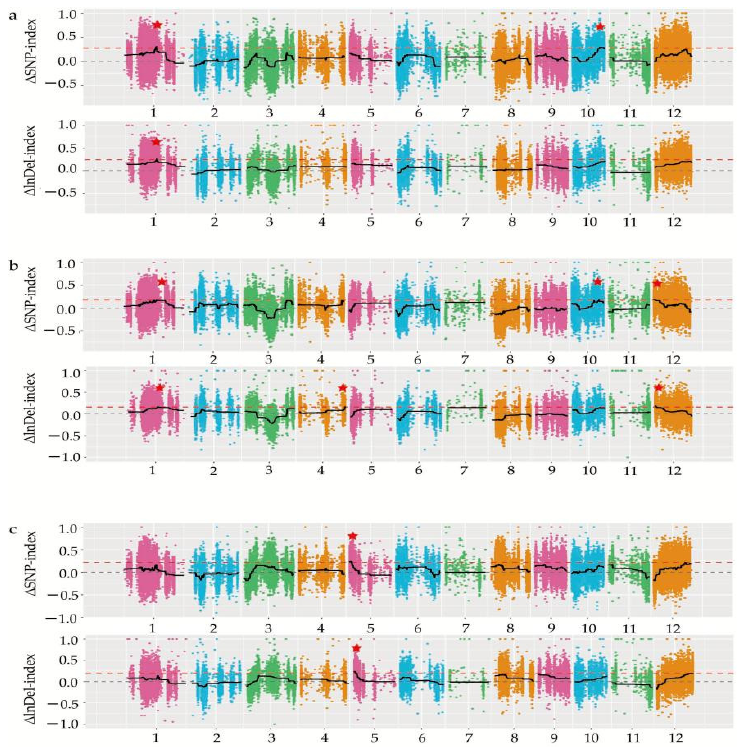
Figure 4. Manhattan plot on the variation tendency of the ∆ indel-index and ∆ SNP-index among L-pool, M-pool, and H-pool associated with GNPP distribution in different chromosomes. ( a ), ∆ indel- index and ∆ SNP-index between L-pool and H-pool; ( b ), ∆ indel-index and ∆ SNP-index between L-pool and M-pool; ( c ), ∆ indel-index and ∆ SNP-index between M-pool and H-pool. Red stars indicate the candidate regions associated with the GNPP. The number on x -axis represents the chromosome number. The values of ∆ indel-index or ∆ SNP-index were calculated and plotted with colored dots. The fitted ∆ indel-index or ∆ SNP-index is shown with the black line, and the threshold line for the 99th percentile is indicated with a red line. Table 4. Analysis of candidate regions associated with the GNPP.